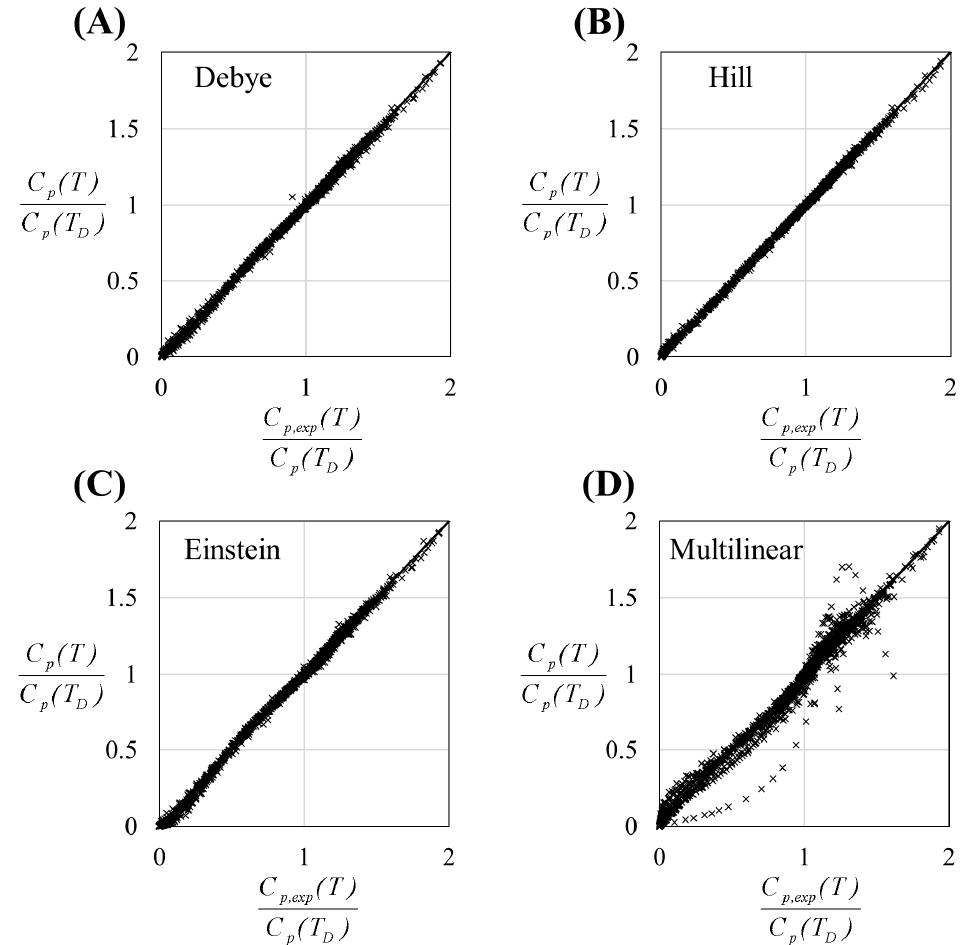
Figure 2. Accuracy of the specific heat models, where a 1:1 correspondence reflects accurate model predictions. For comparative purposes, predicted specific heat ( C p ) and experimental specific heat ( C p,exp ) were normalized by specific heat at each solid’s Debye Temperature, C p ( T D ), which yields unitless graphs. ( A ) Debye Model training data ( x -axis) versus Debye Model predictions ( y -axis) across all 53 solids. ( B ) Hill Equation training data ( x -axis) versus Hill Equation predictions ( y -axis) across all 53 solids. ( C ) Einstein Solid training data ( x -axis) versus Einstein Solid predictions ( y -axis) across all 53 solids. ( D ) Multilinear Model training data ( x -axis) versus Multilinear Model predictions ( y -axis) across all 53 solids.